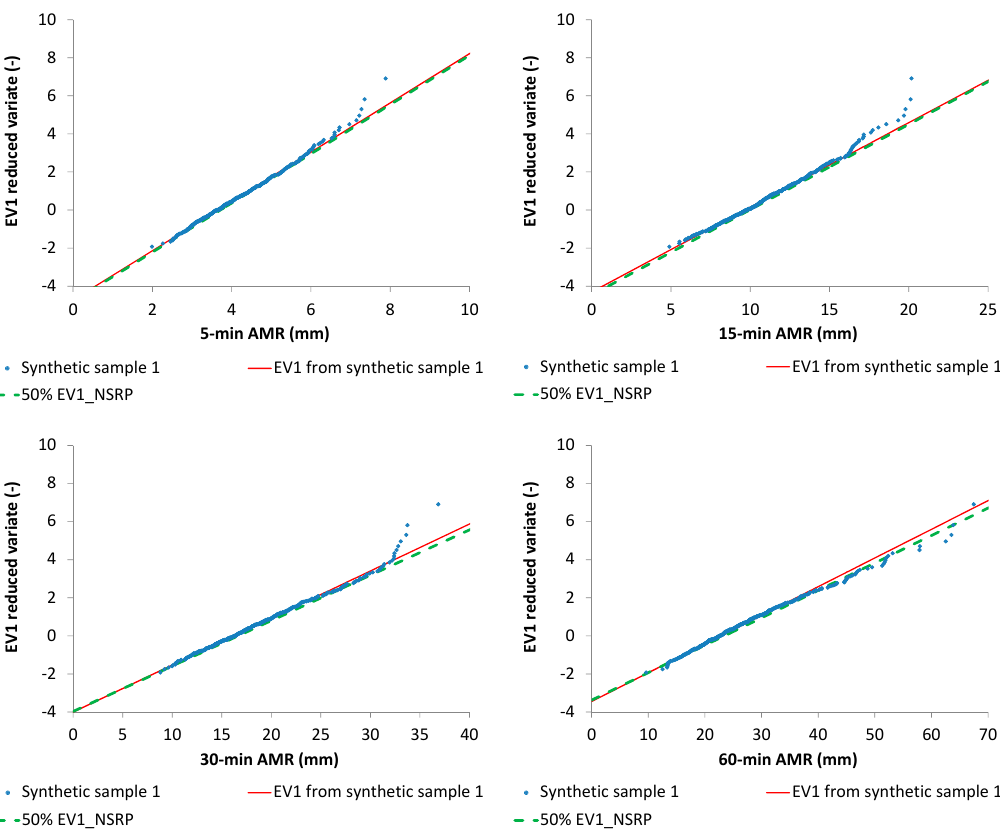
Figure 9. Synthetic sample 1: EV1 probabilistic plots with AMR series, their EV1 theoretical curves and median EV1 curves from NSRP generation.